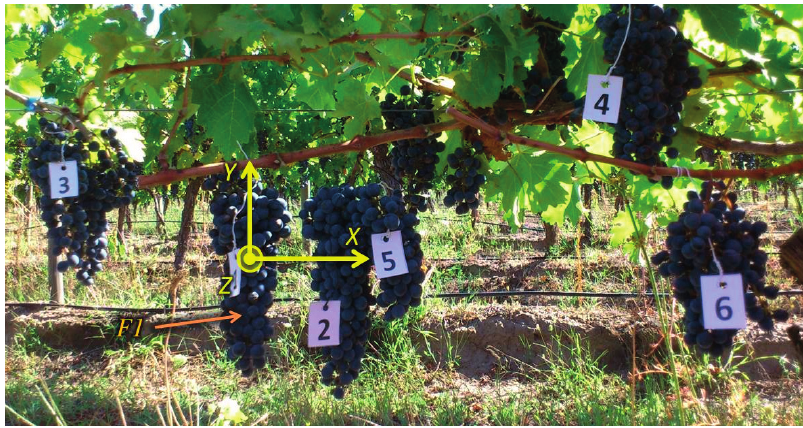
Figure 16. Ground truth data acquisition for a scene of the vineyard.